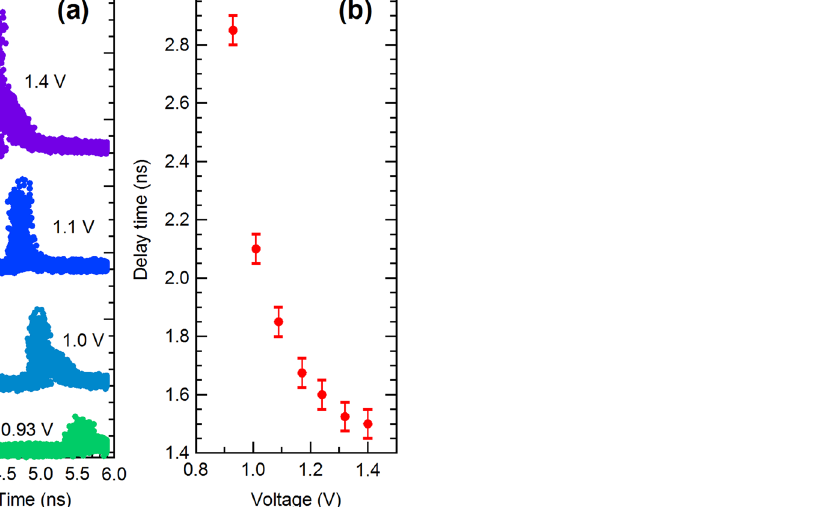
Figure 6. ( a ) Waveforms of the optical pulses from the laser diode generated with different driving voltages ranging from 0.9 to 1.4 V (for easy observation of the pulse shapes, the electrical pulse widths are tuned to cut off the steady state). ( b ) Delay times of the optical pulses from the laser diode generated with different driving voltages ranging from 0.9 to 1.4